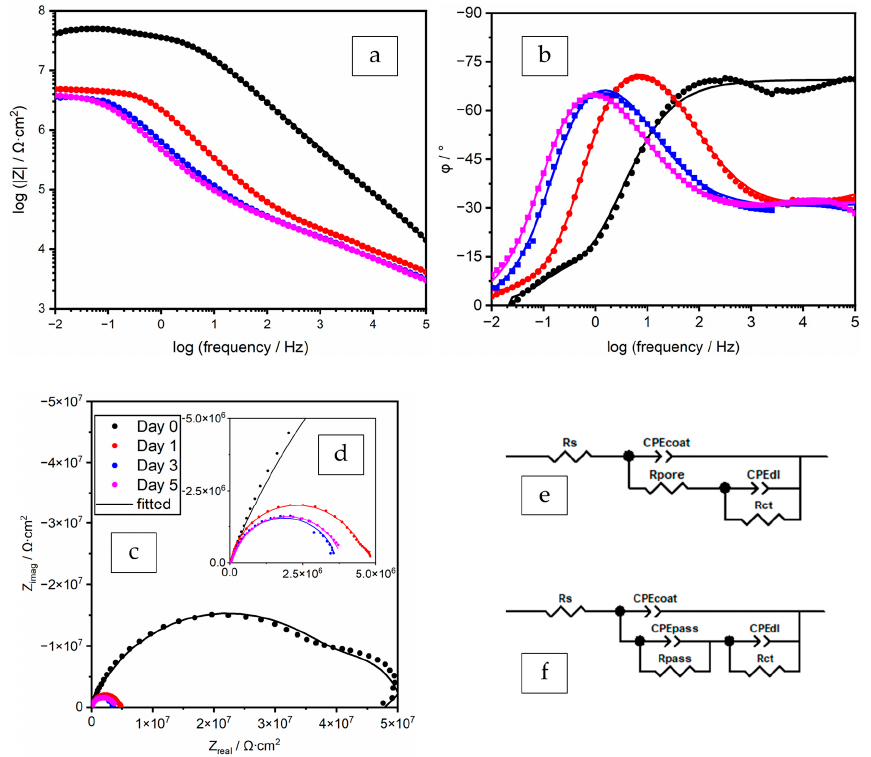
Figure 6. EIS spectra ( a – c ) and the Nyquist plot with the enlarged high-frequency region ( d ) and EECs for data fitting ( e , f ), coating prepared by the formula ZP–02%-EB.